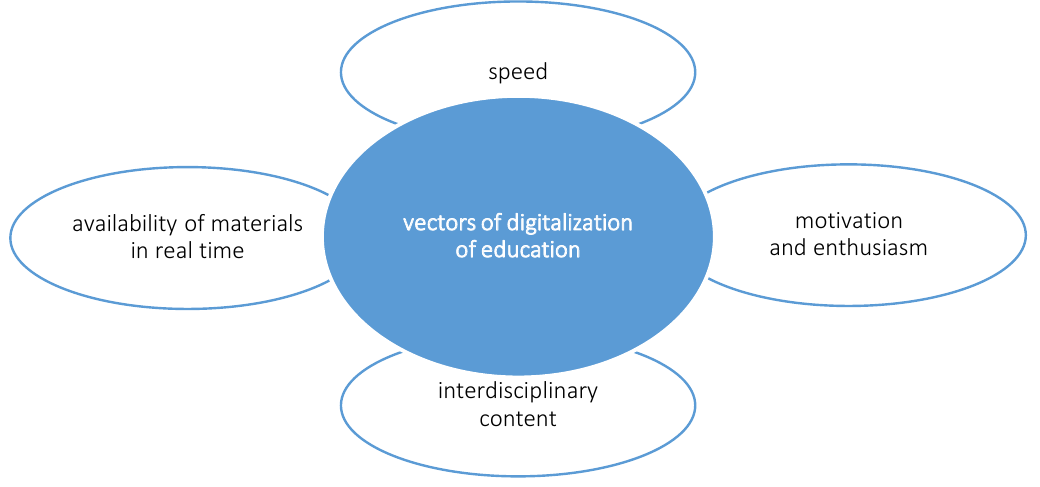
Figure 5. Vectors of digitalization of Ukrainian